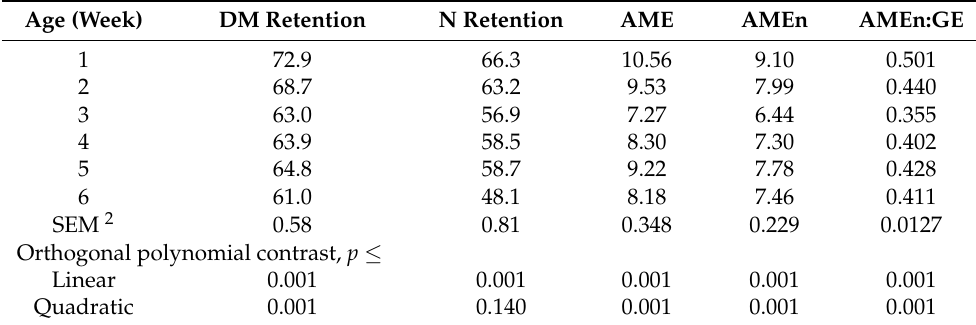
Table 4. Influence of broiler age on the retention (% of intake) of dry matter (DM) and nitrogen (N), apparent metabolizable energy (AME; MJ/kg DM), nitrogen-corrected AME (AMEn; MJ/kg DM) and the ratio between AMEn and gross energy (AMEn:GE; MJ/MJ) of canola meal 1 . Age (Week) DM Retention N Retention AME